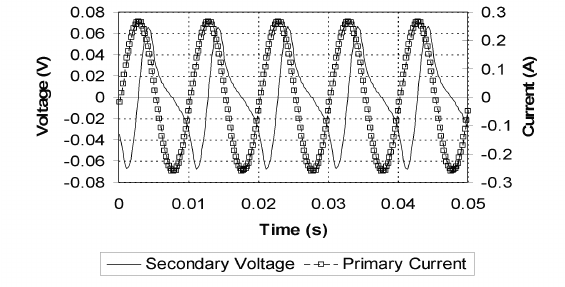
Figure 15: FCL BH Curve under Fault Conditions (Load = 0.5 Ohm